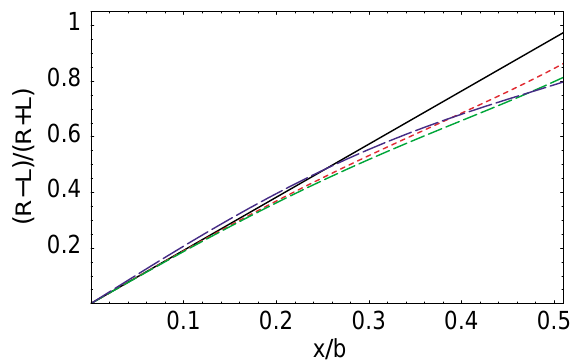
FIG. 4. (Color) Same as Fig. 2, but with s x (cid:1) 0 , s y (cid:2) b (cid:1) 0.2 . for a more complicated BPM geometry with realistic strip lines protruding inside a circular pipe, it was demonstrated by measurements (see [5]) and by numerical 3D modeling [6] that the effects of field distortions near the strip line edges can be accounted for by integrating the wall cur- rent within an effective transverse extent of the strip lines (slightly larger than their width) in a simple smooth-pipe model with the effective pipe radius taken to be an aver- age of the strip line inner radius and the inner radius of the beam pipe.